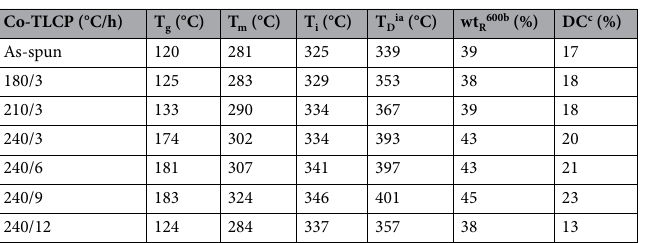
Table 4. Thermal properties of the heat-treated Co-TLCP fibers. a At a 2% initial weight-loss temperature. b Weight percent of residue at 600 °C. c Degree of crystallinity.